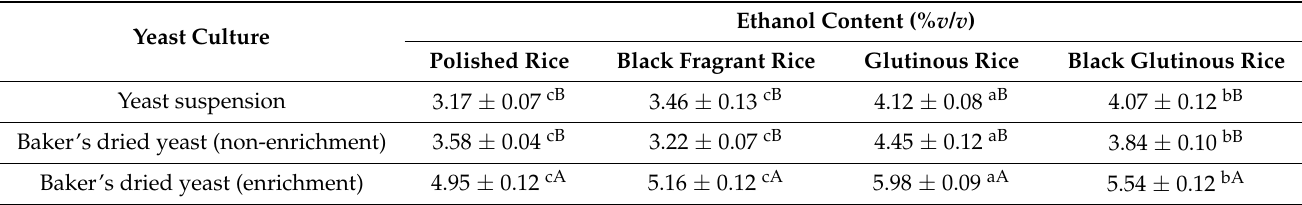
Table 1. Ethanol production of each rice substrate using various starter cultures. Yeast